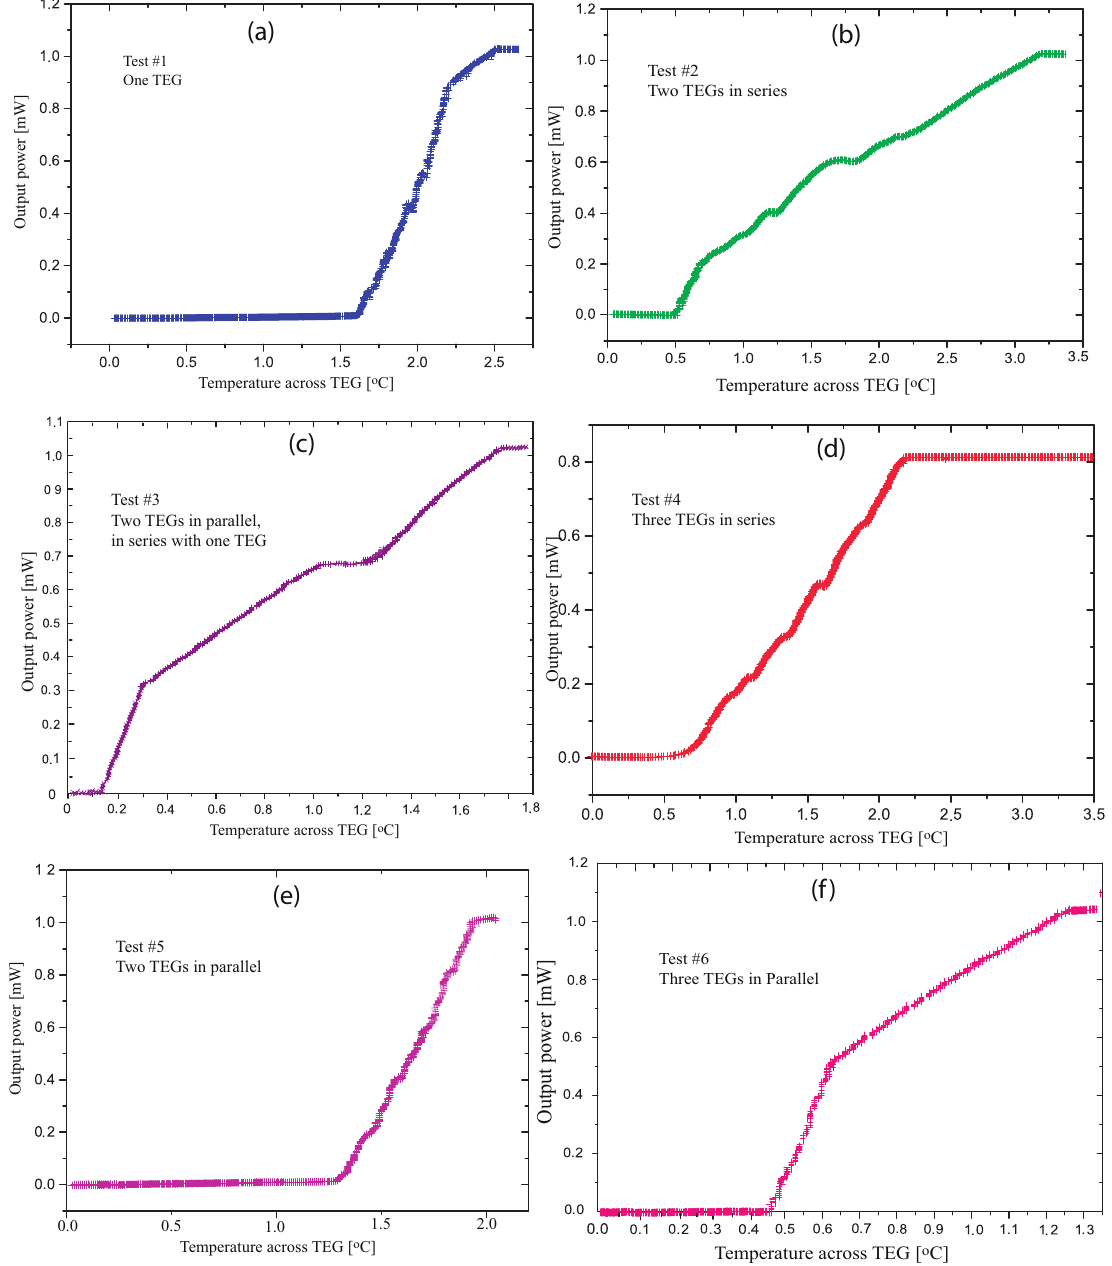
Figure 9. Calculated output power as a function of the temperature gradient across the TEG, from the measured values of V 2 and V 1 ( V 1 verified to be always at 4.2 V when V 2 (cid:54) = 0), for all tests: ( a ) one single TEG; ( b ) two TEGs in series; ( c ) two TEGs in parallel in series with 1 TEG; ( d ) three TEGs in series; ( e ) two TEGs in parallel; ( f ) three TEGs in